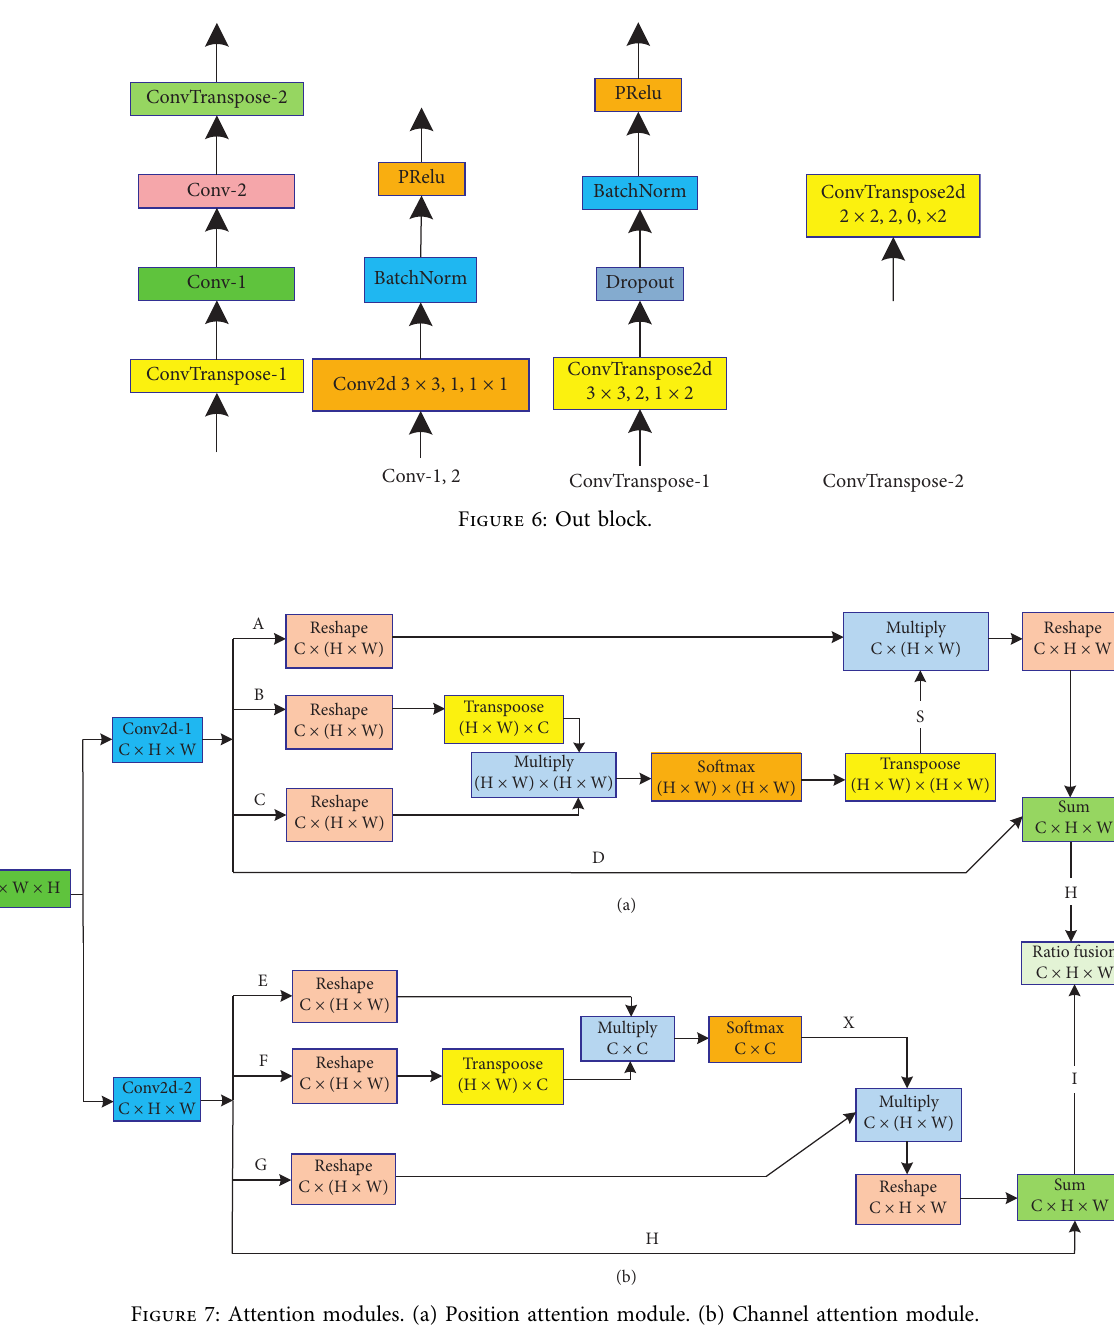
Figure 7: Attention modules. (a) Position attention module. (b) Channel attention